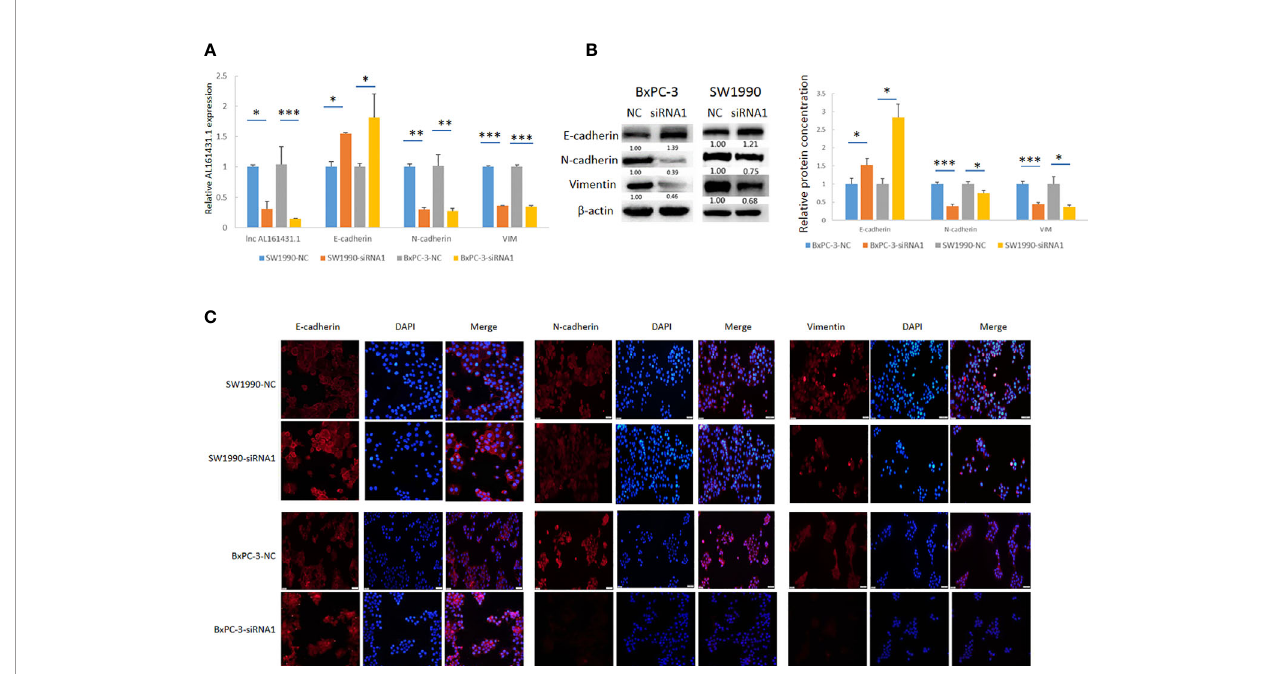
FIGURE 6 | Knockdown of lncRNA AL161431.1 inhibited EMT. (A) qRT-PCR showing the knock down of lncRNA AL161431.1, and the corresponding changes in E-cadherin, N-cadherin, and vimentin in SW1990 and BxPC-3 cells; (B) Western blots showing the changes in protein level in E-cadherin, N-cadherin, and vimentin in SW1990 and BxPC-3 cells after transfection of scrambled siRNA or siRNA1; (C) Immuno fl uorescence analysis showing the change of expression of E-cadherin, N-cadherin, and vimentin in SW1990 and BxPC-3 cells after transfection of scrambled siRNA or siRNA1 (200x). *p < 0.05, **p < 0.01, ***p <